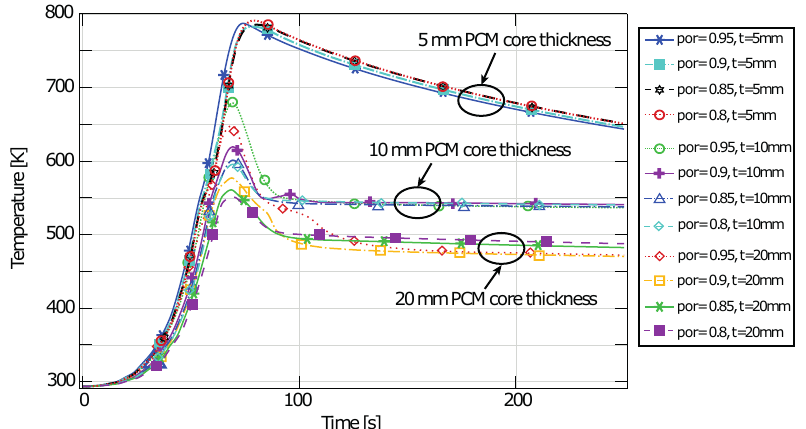
) and porosities ( (cid:101) ) of the PCM